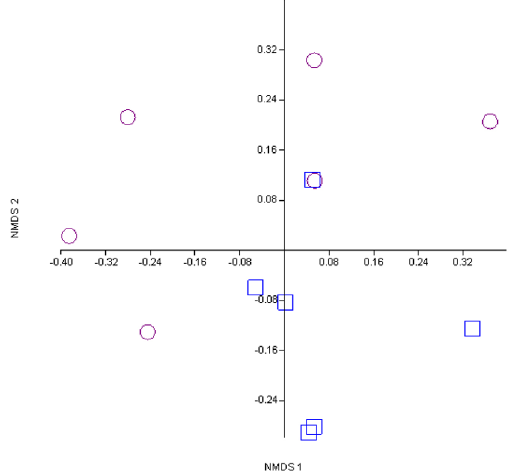
Figure 3. NMDS graph for the sampling periods based on biomass of trophic categories. □ = flood season and ○ = dry